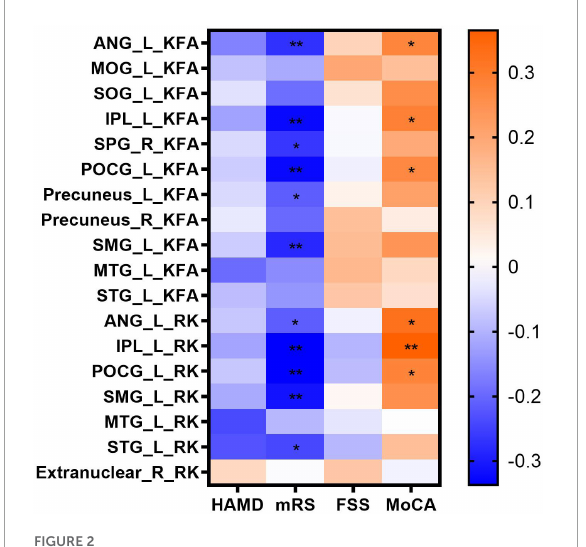
FIGURE2 Correlations between clinical scale scores and KFA and RK values in abnormal brain regions in patients with anti-NMDAR encephalitis. Statistical differences are * P < 0.05, ** P < 0.01. Anti-NMDAR, anti-N-methyl-D-aspartate receptor; HAMD, Hamilton Depression Scale; mRS, Modified Rankin Scale; FSS, Fatigue Severity Scale; MoCA, Montreal Cognitive Assessment; KFA, kurtosis fractional anisotropy; RK, radial kurtosis; ANG_L, left angular gyrus; MOG_L, left middle occipital gyrus; SOG_L, left superior occipital gyrus; IPL_L, left inferior parietal but supramarginal and angular gyrus; SPG_R, right superior parietal gyrus; POCG_L, left postcentral gyrus; Precuneus_ L, left precuneus; Precuneus_ R, right precuneus; SMG_L, left supramarginal gyrus; MTG_L, left middle temporal gyrus; STG_L, left superior temporal gyrus.